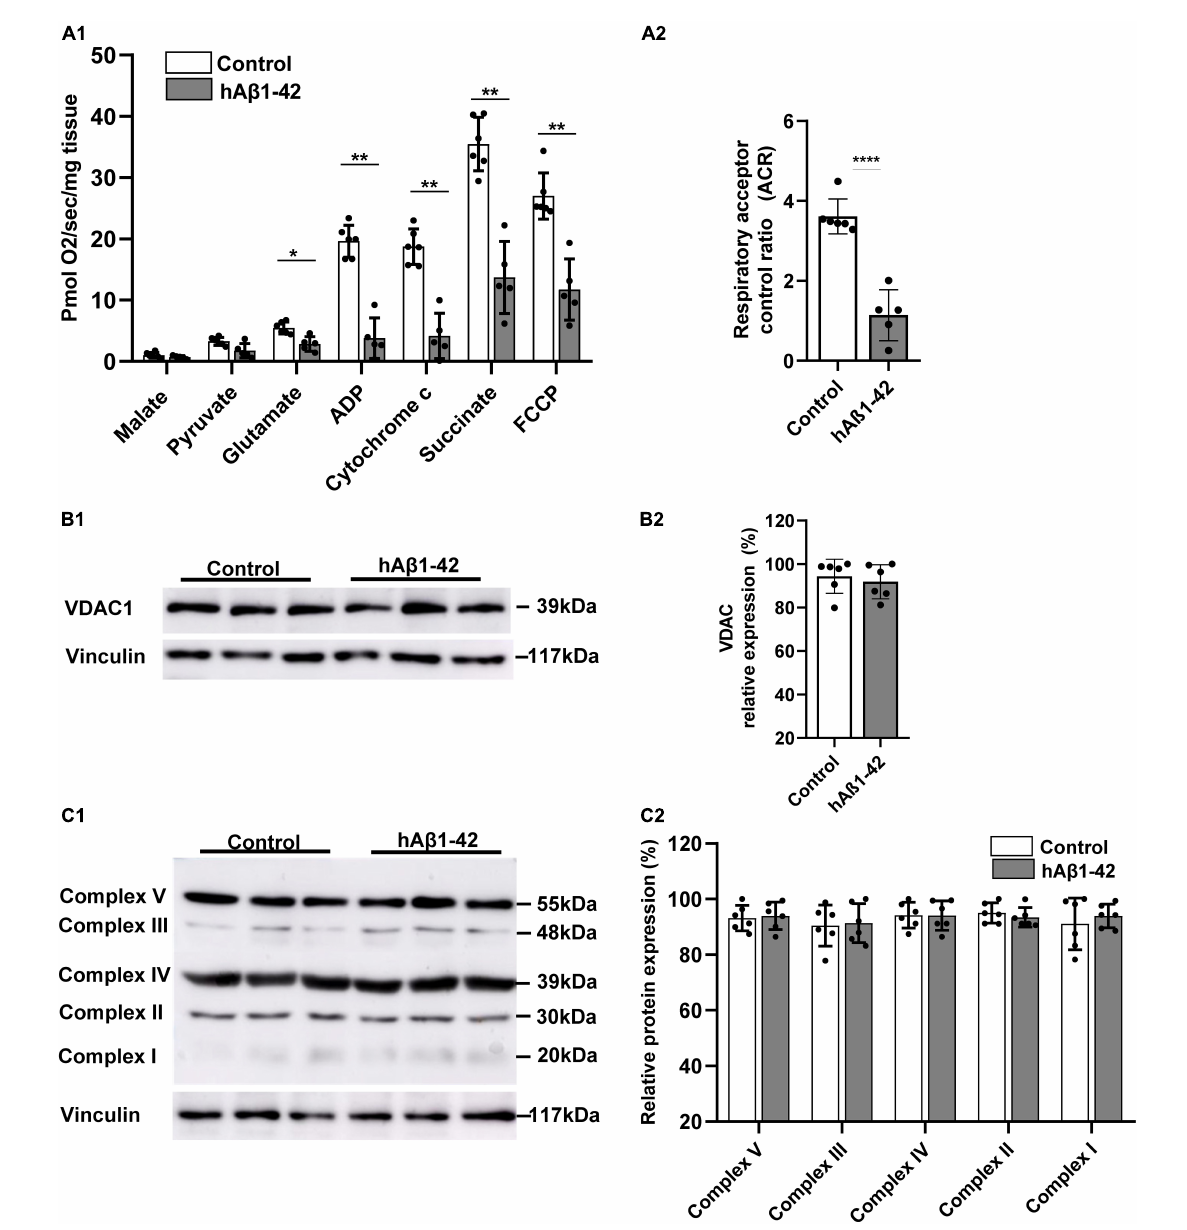
FIGURE1 Impact of hA β 1 − 42 on mitochondrial respiration and function in the entorhinal cortex. (A1) Bar graphs represent mitochondrial substrate utilization in permeabilized entorhinal tissue previously treated with 1 µ M hA β 1 − 42 for 3 h vs. control tissue, assessed through high-resolution respirometry ( n = 5–6). (A2) Graph showing the acceptor control ratio (ACR) which measures the relative efficiency of phosphorylation and is determined by dividing ADP by glutamate average rates of respiration. hA β 1 − 42 treatment significantly reduced the ACR relative to control. (B1) Representative immunoblots of mitochondrial membrane and gatekeeper protein voltage-dependent anion channel 1 (VDAC1) and vinculin (loading control) in entorhinal lysates following incubation in control medium or hA β 1 − 42 . (B2) Bar graphs showing the normalized protein expression of VDAC1 ( n = 6). (C1) Representative immunoblots of mitochondrial complex I to V with total OXPHOS rodent antibody cocktail with vinculin serving as a loading control. (C2) Graphs showing normalized data for all five mitochondrial subunits in hA β 1 − 42 -treated slices vs. the largest expression in the control group ( n = 6) (* p < 0.05; ** p < 0.01; **** p <